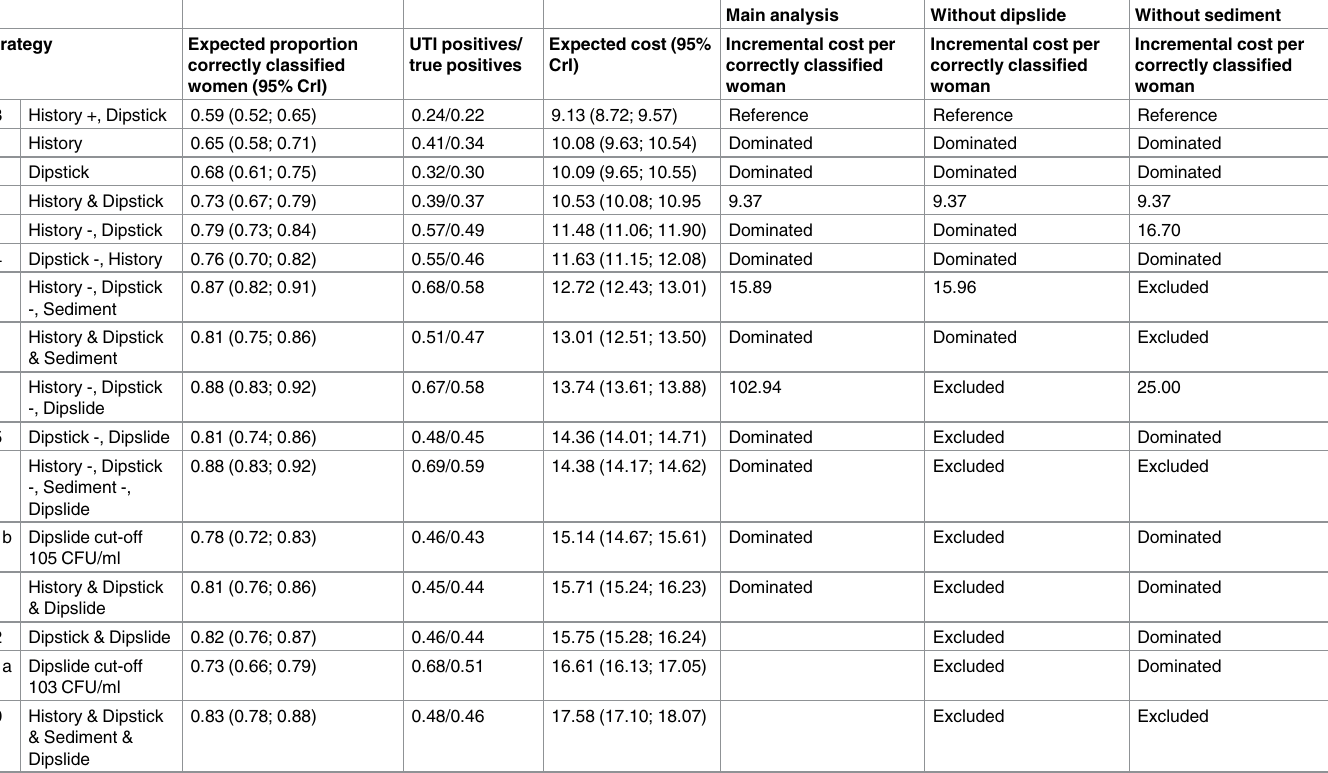
Table 3. Expected proportion of correctly classified women, expected costs and incremental cost per correctlyclassified woman for all test strate- gies in the main analysis and the two univariate sensitivity analysesexcluding strategies containing a dipslide and strategies containing a sediment.